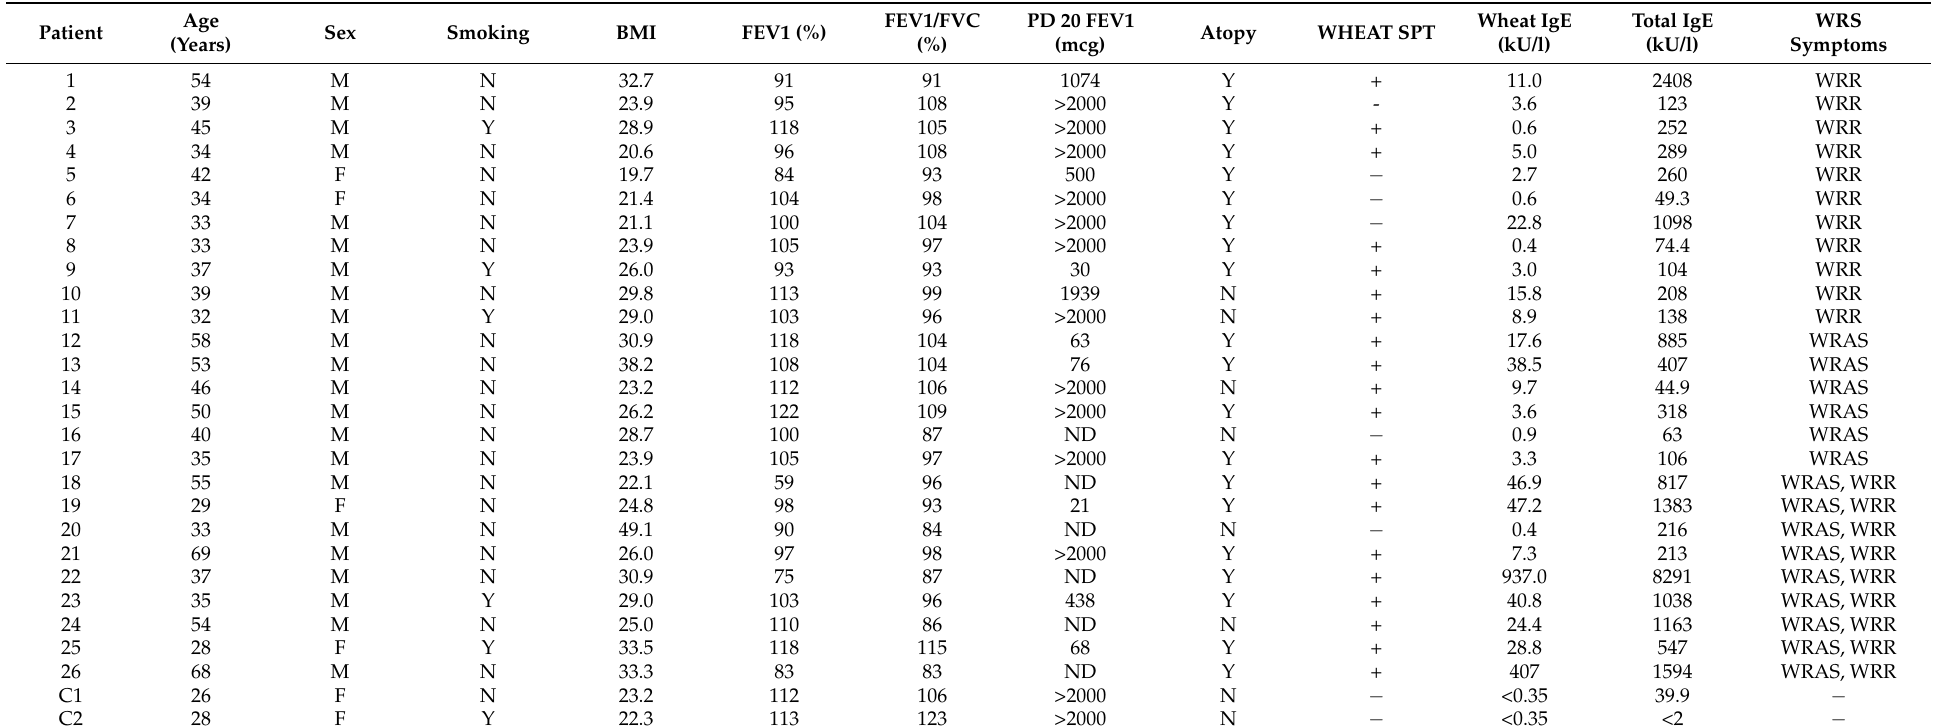
Table 2. Demographic and clinical characteristics of work-related wheat allergic bakers and